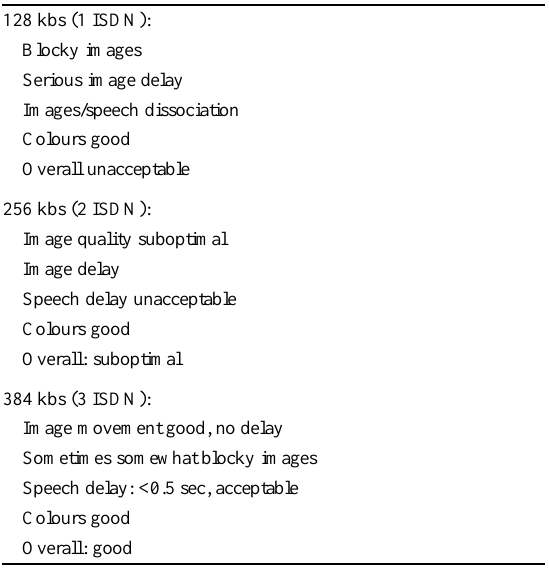
Evaluation by ten independent observers (expert pathologists) of the different qualities of the video-conferencing-telepathology